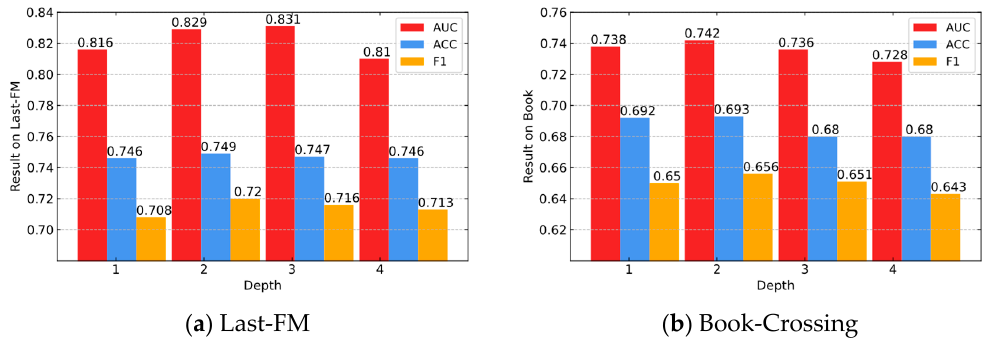
Figure 9. The results of different propagation depths on two datasets. ( a ) Results on the Last-FM dataset. ( b ) Results on the Book-Crossing dataset.